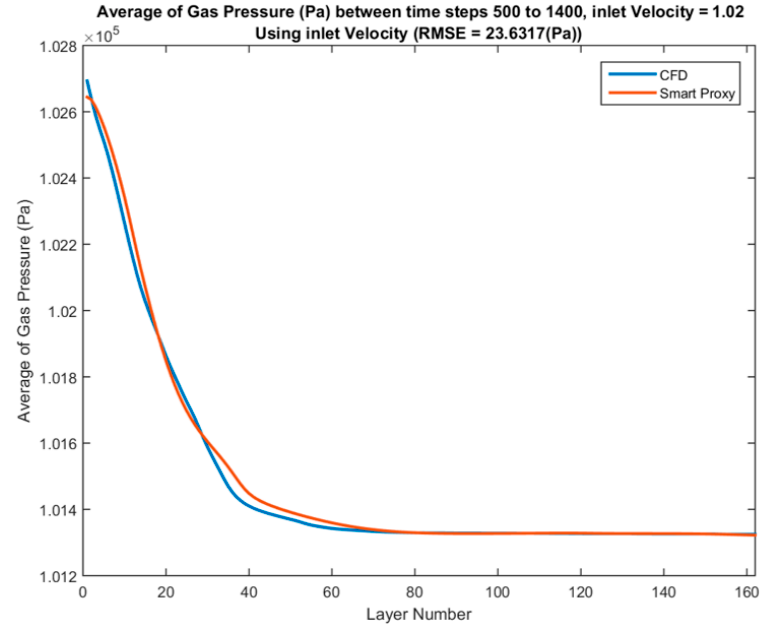
Figure 47. Spatial average profile of CFD and smart proxy results for gas pressure (Pa), averaged over time steps 500 to 1400 for blind test condition of V in = 1.02 m/s. Fluids 2019 , 4 , x